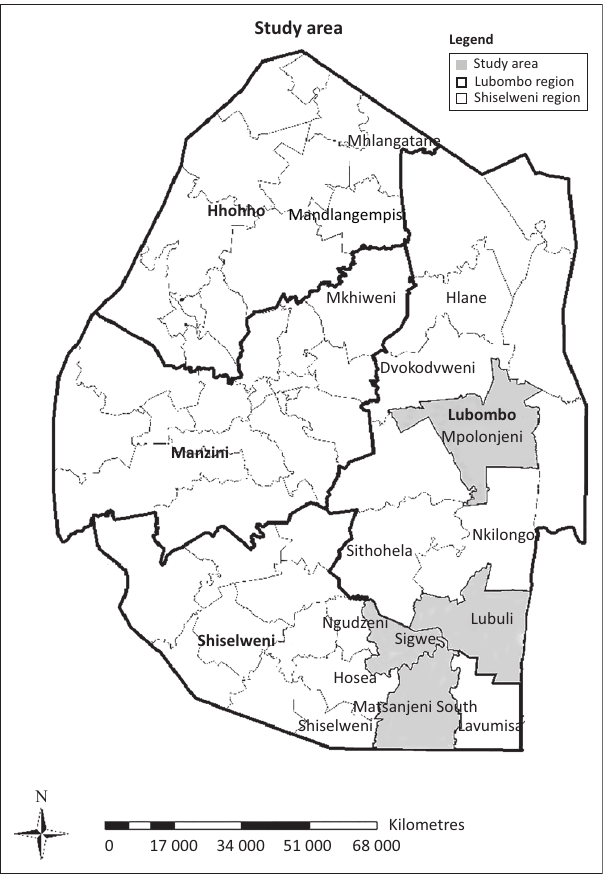
FIGURE 3: Map of study